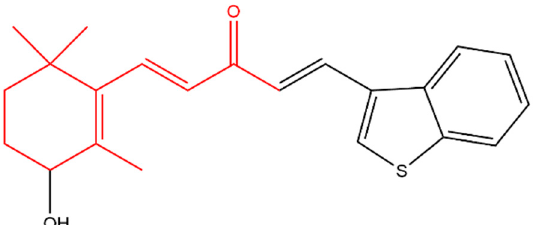
Figure 9. (1 E ,4 E )-1-(Benzo[b]thiophen-3-yl)-5-(3-hydroxy-2,6,6-trimethylcyclohex-1-en-1-yl)penta-1,4-dien -3-one. The β -ionone moiety is shown in red.